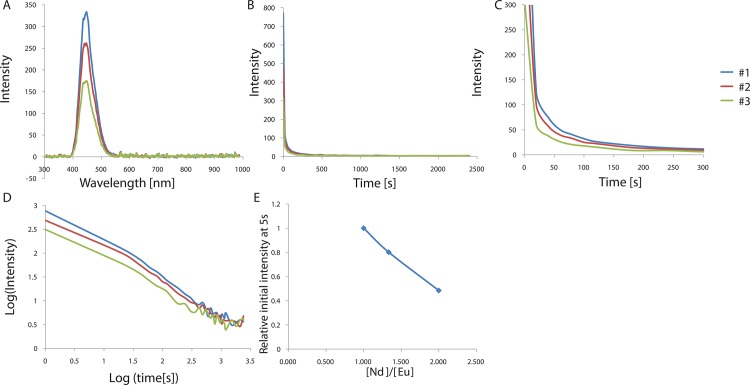
(A) Emission spectrum of CaAl2O4:Eu2+, Nd3+ crystals depending on [Nd3+]/[Eu2+] ratio. (B) Decay curves depending on [Nd3+]/[Eu2+] ratio. (C) Magnified views of the graph in (B). (D) Decay curves in log scale depending on [Nd3+]/[Eu2+] concentration. (E) Relative initial intensity measured at 5s (relative values where the value of control sample #1 is 1.0) depending on [Nd3+]/[Eu2+] concentration.